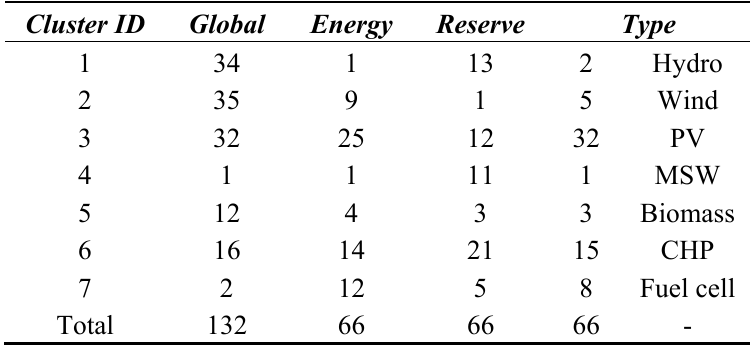
Table 3. DG resources